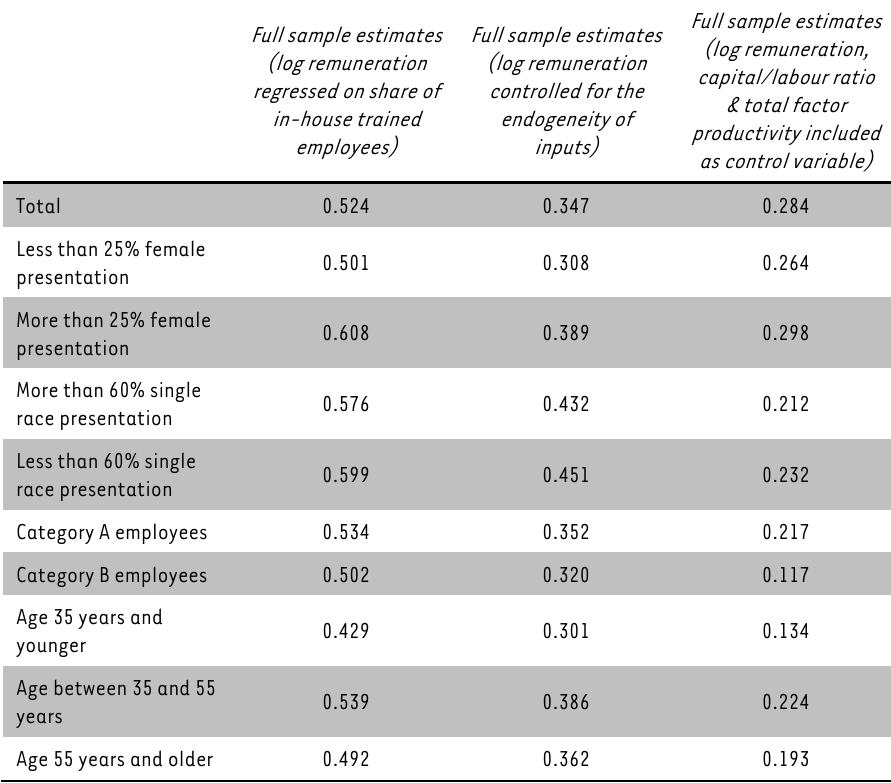
TABLE 3: Panel data estimates for the employee remuneration impacts of in-house training opportunities (for the different diversity